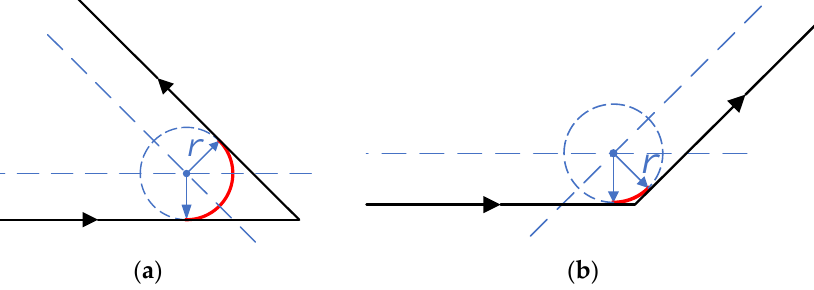
Figure 3. Turning strategy with intersecting working paths. ( a ) Acute angle; ( b ) obtuse angle.